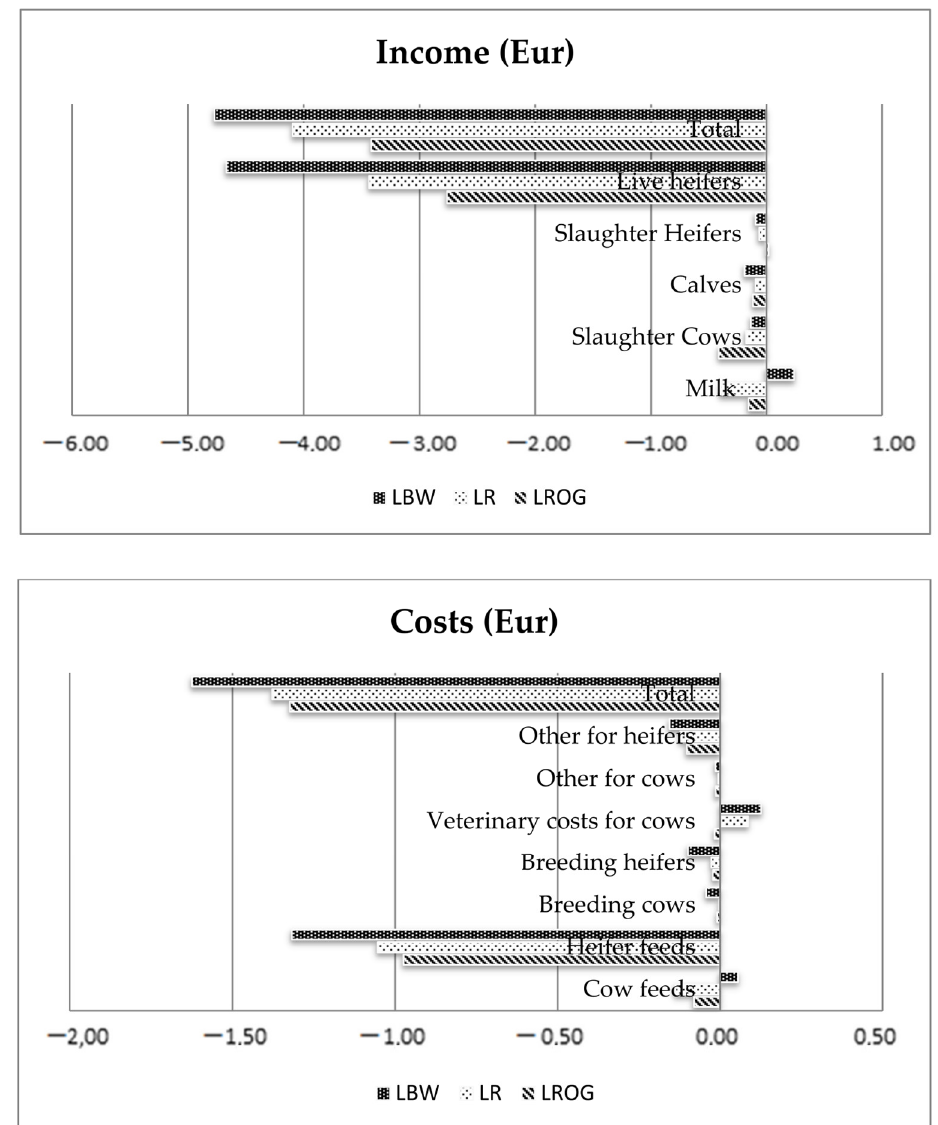
Figure 3. Economic income and costs (in Euro) caused by an increase in late calf mortality rate of 1 percentage point for the breeds LBW, LR and LROG.